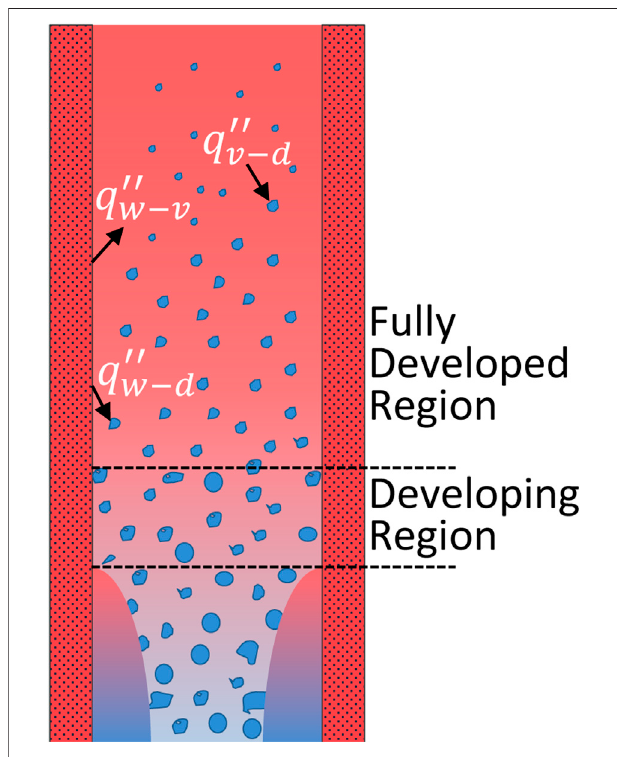
FIGURE 1 | Typical fl ow and heat transfer patterns in the post-dryout region; q ′′ w − v : convective and radiative heat transfer between wall and vapor, q ′′ w − d : contact and radiative heat transfer between wall and droplet, q ′′ v − d : interfacial and radiative heat transfer between vapor and droplet.